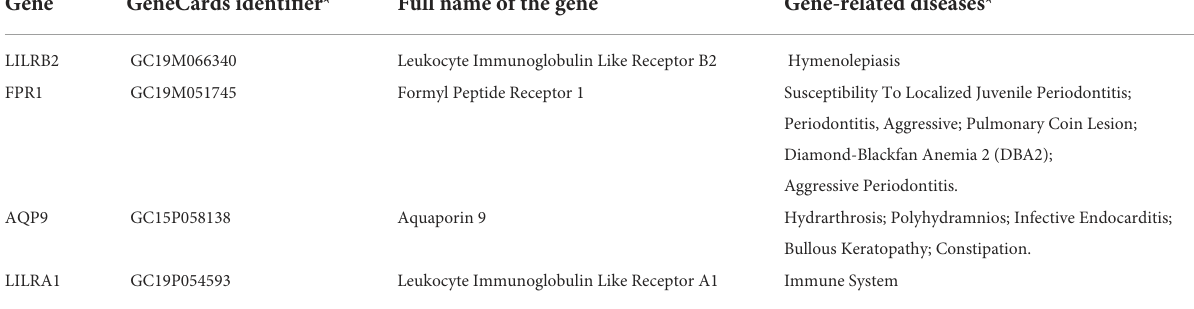
TABLE 3 The hub genes in Acute Unilateral